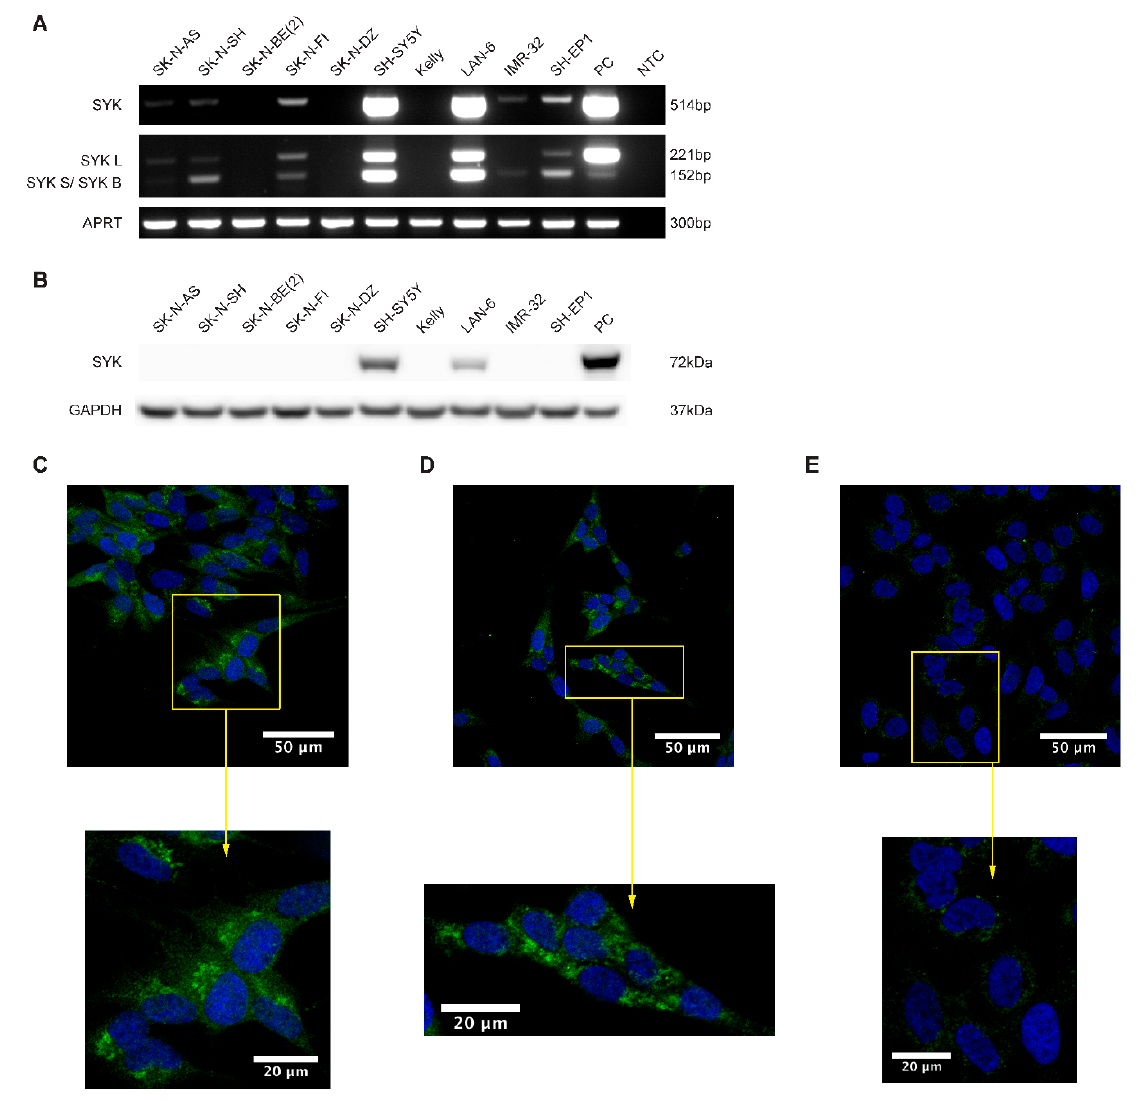
Figure 2 . Cont . Figure 2. Cont